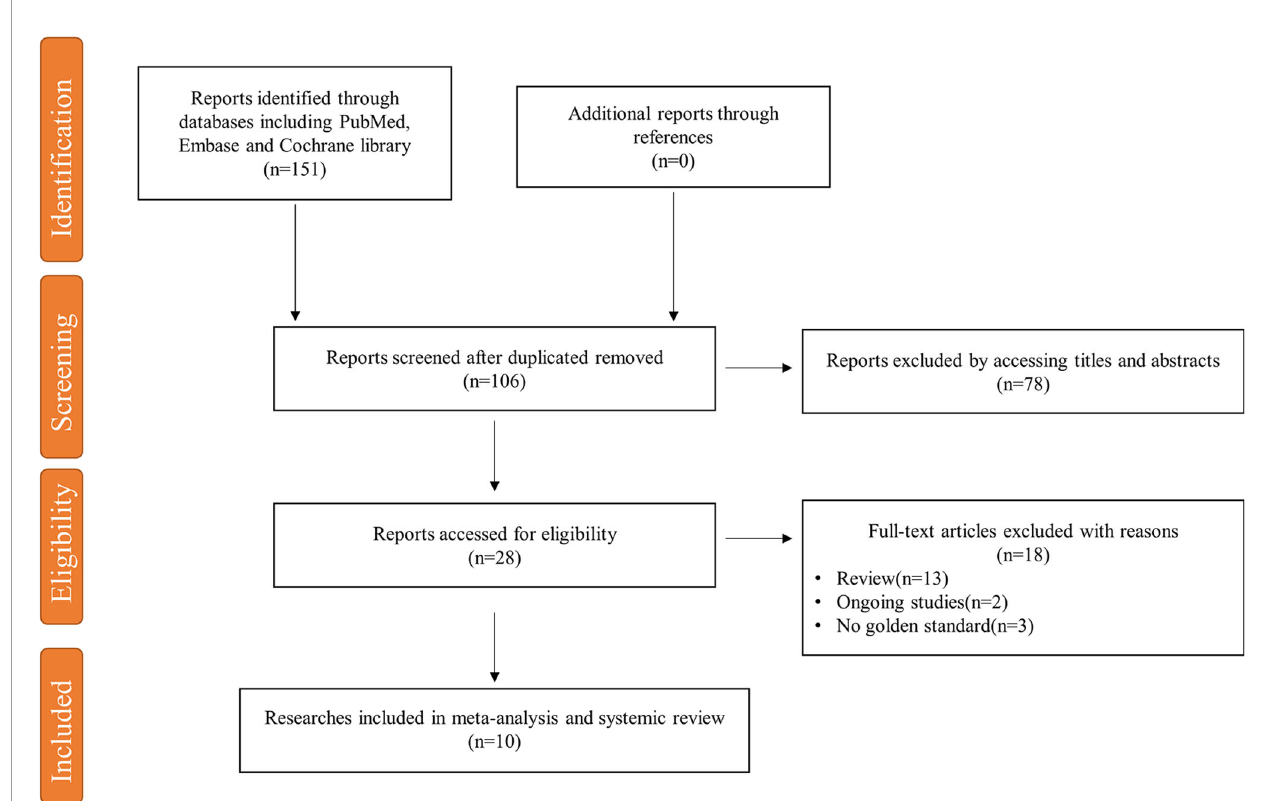
FIGURE 1 | Flowchart of selected studies for inclusion in the